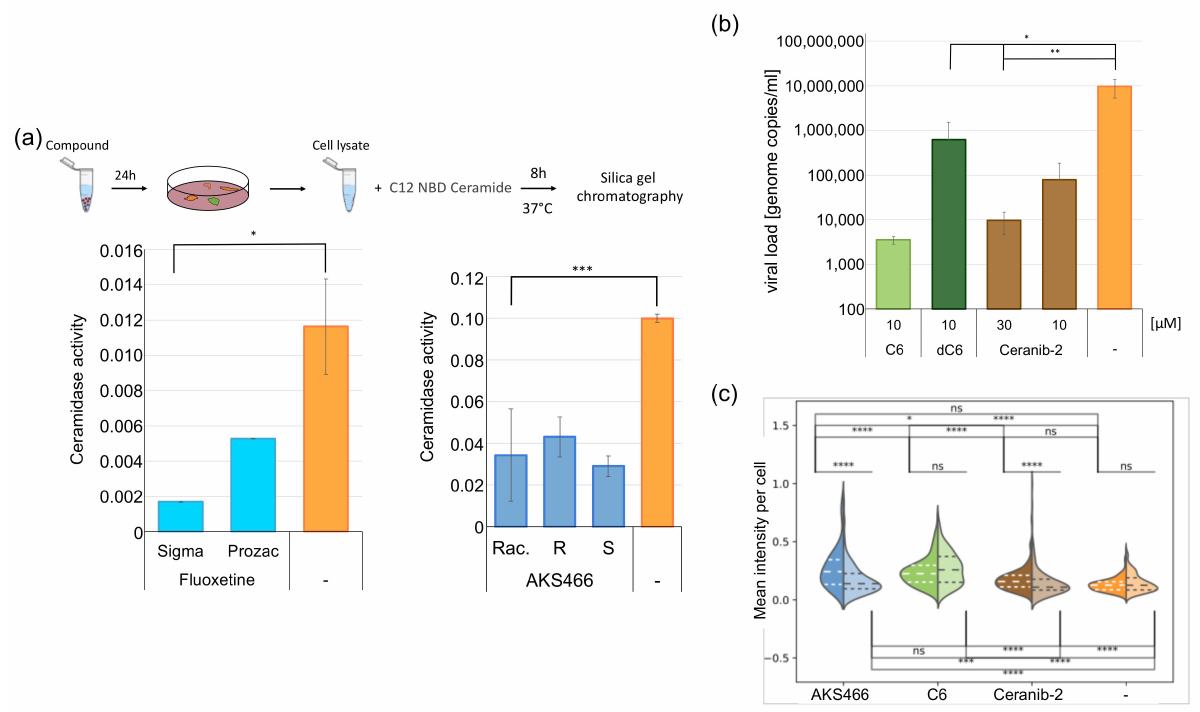
Figure 6. AKS466 and fluoxetine suppress the activity of the acid ceramidase . ( a ) Cells were incubated with the compounds for 24 h, and ceramidase activity was measured. ( b ) Ceramides inhibit SARS-CoV-2 replication. Huh-7 cells were incubated with C6 ceramides, the ceramidase inhibitor ceranib-2 or dihydroxyl C6, and infected with SARS-CoV-2. Viral loads were measured by RTqPCR. ( c ) Determination of cellular ceramides concentrations in Huh7 cells (significance: upper panel) and SARS-CoV-2-infected cells (significance: lower panel) using a ceramide-specific antibody (ns: p > 0.005; *: 0.005 ≥ p > 0.001; **: 0.001 ≥ p > 0.0001; ***: 0.0001 ≥ p > 00001; ****: 0.0001 ≥ p